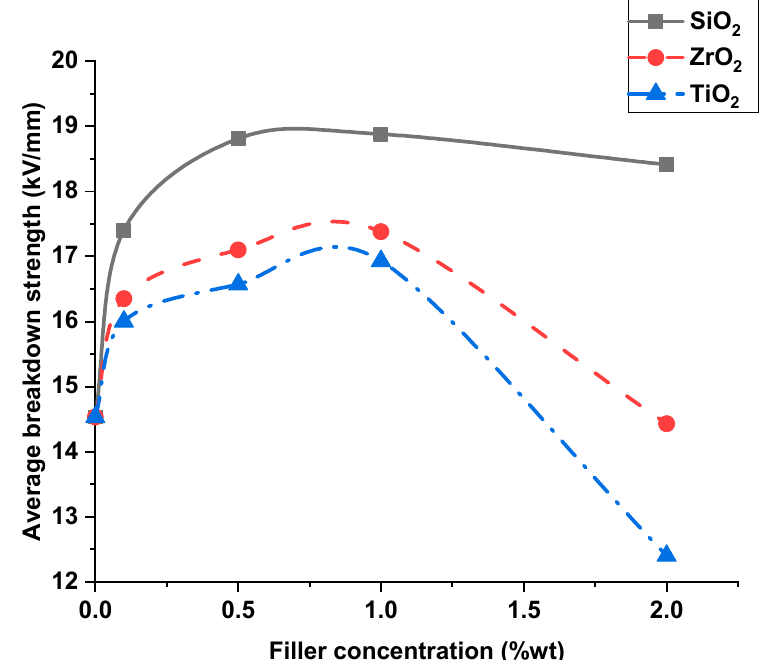
Figure 9. Average breakdown strength of silicone rubber.